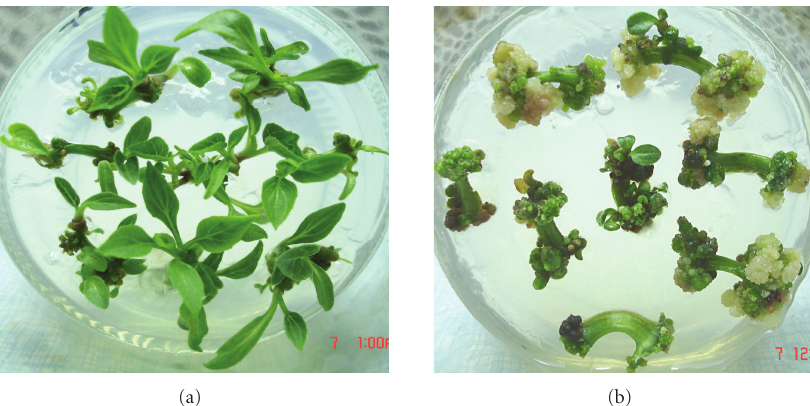
Figure 1: Cultures of petiole explants on regeneration medium containing 0.3mg/L BA and 0.01 mg/L NAA. (a), For 40 days without subculture; (b), For 40 days after being cultured on a medium containing 0.3mg/L BA, 0.01 mg/L NAA and 120 mg/L colchicine for 30 days.